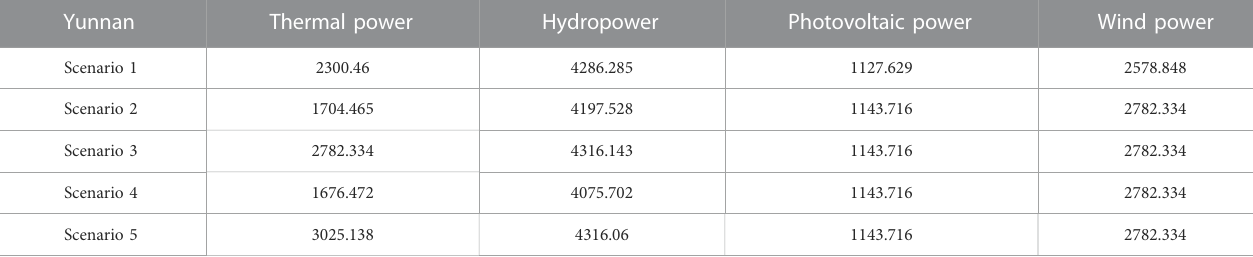
TABLE 2 Power utilization hours of different scenarios in Yunnan (Unit: Hour).